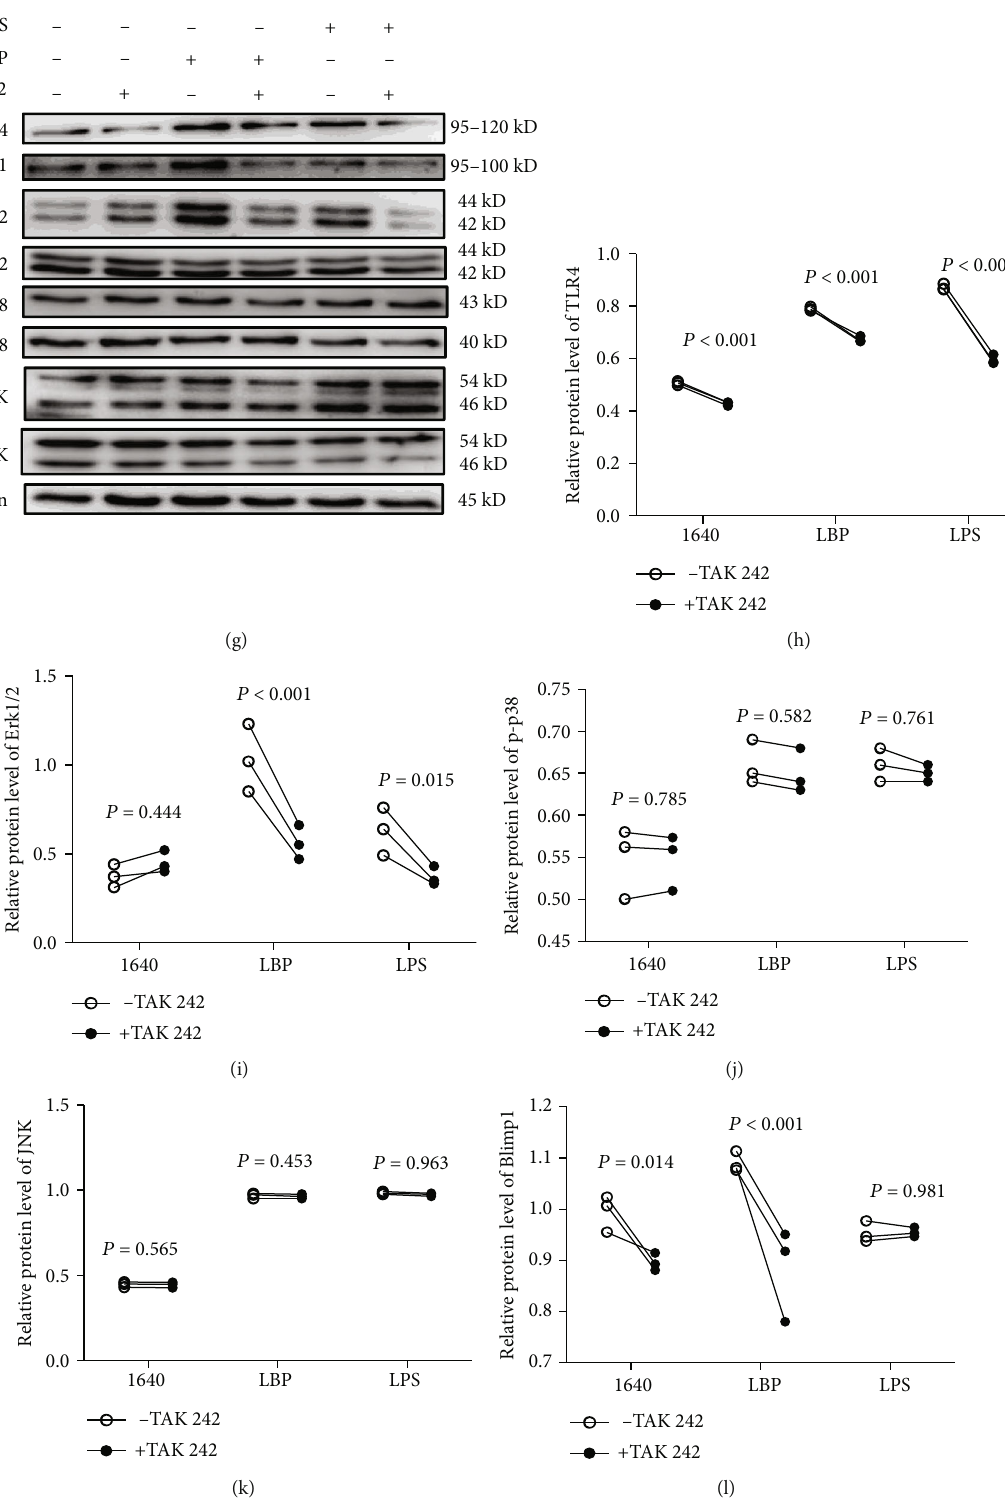
Figure 4: LBP regulate DCs maturation via TLR4-MAPK. DCs were pretreated with TAK 242 (10 μ M) for 1h and then cocultivated with LPS (100ng/mL) or LBP (200 μ g/mL) for 30 min. The mRNA and protein expression of TLR4 associated molecules was checked by Taqman-PCR and Western blot as TLR4 (a and g), Erk1 (b and h), Erk2 (c and i), p38 (d and j), JNK (e and k), and Blimp1 (f and l). Values are the mean and SD of 3 independent experiments. For the above fi gures, here, ∗ P < 0 : 05 , ∗∗ P < 0 : 01 , and ∗∗∗ P < 0 : 001 were considered statistically signi fi cant di ff erent from